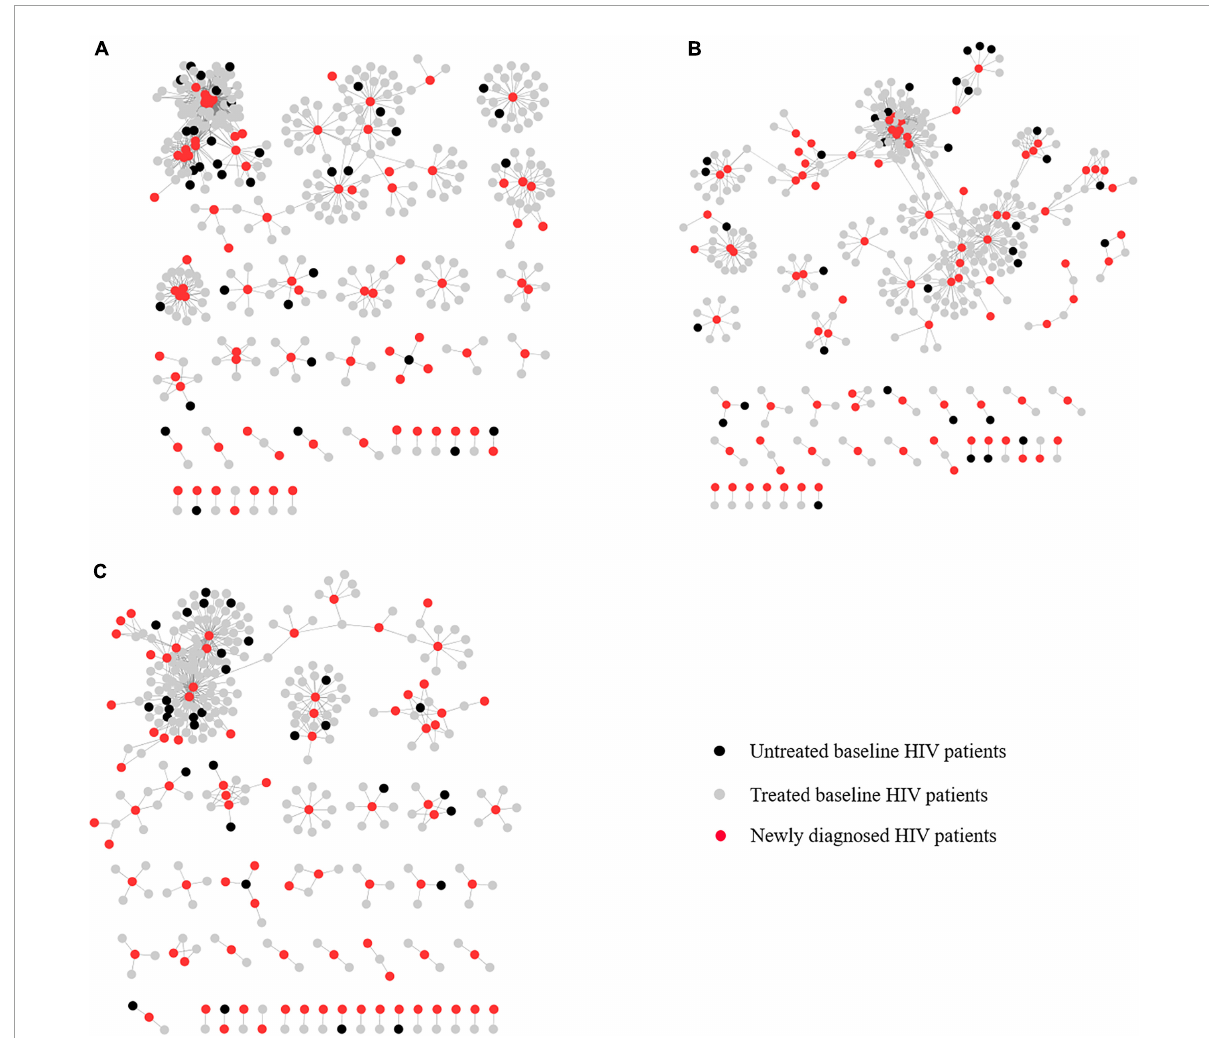
FIGURE1 Transmission network of genetic linkage between newly diagnosed patients with HIV and those at baseline in Guangxi of China. (A) Genetic linkage between newly diagnosed patients with HIV in 2016 and those at baseline in 2015. (B) Genetic linkage between newly diagnosed patients with HIV in 2017 and those at baseline in 2016. (C) Genetic linkage between newly diagnosed patients with HIV in 2018 and those at baseline in